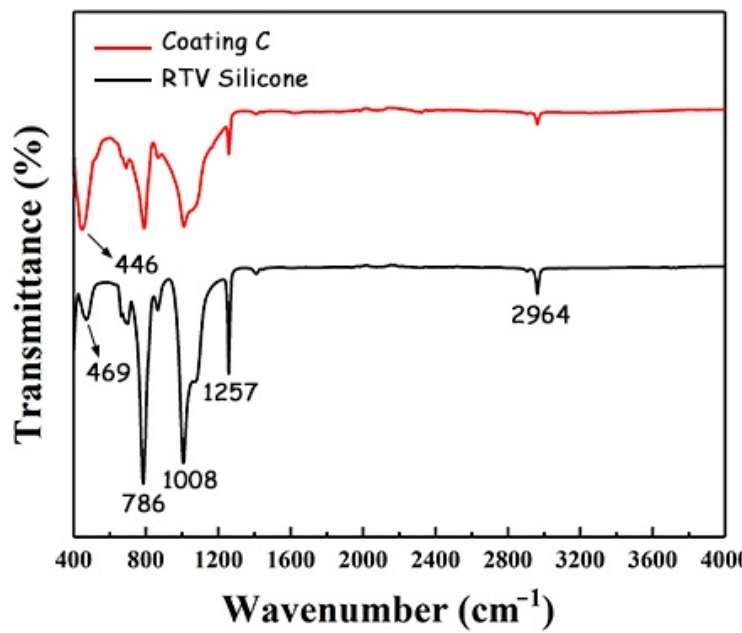
Figure 4. FTIR spectra of coating C and RTV silicone.